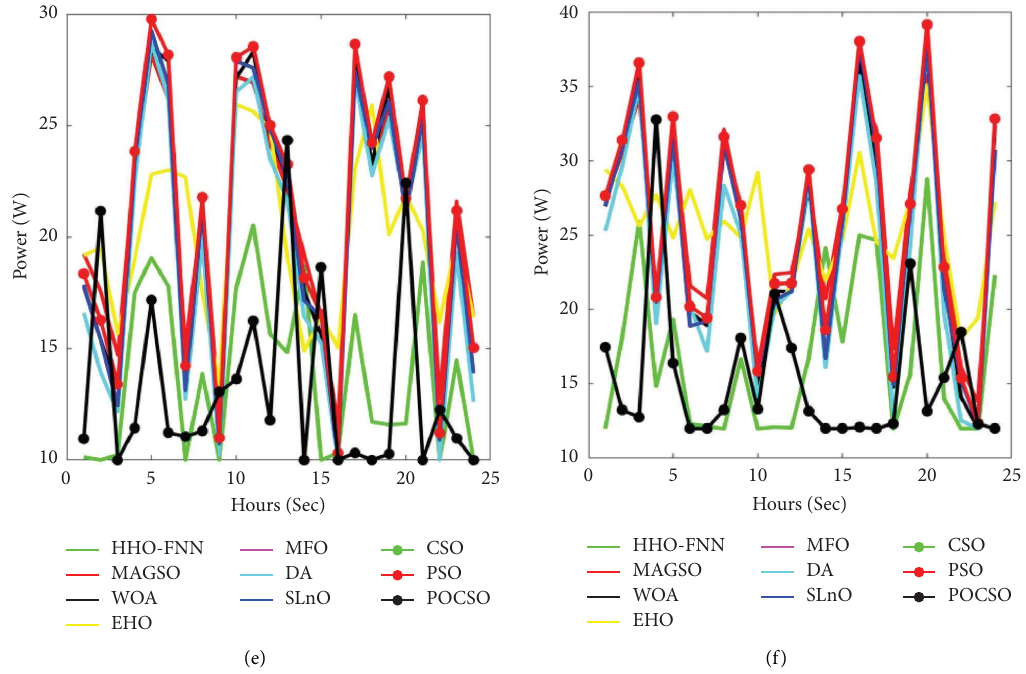
Figure 6: Optimal power generation bounds for IEEE-30 bus system of the proposed and existing methods for (a) Gen 1, (b) Gen 2, (c) Gen 3, (d) Gen 4, (e) Gen 5, and (f) Gen 6. Table 2: Optimal power generation bounds for IEEE-14 bus system for POCSO at ra � ra 1